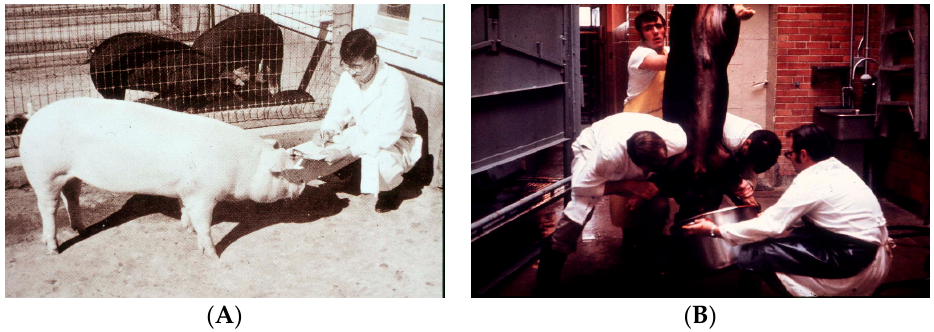
Figure 8. ( A ). This hog was treated with 6.25 mg vitamin D 2 by Dr. Suda; ( B ) the blood was then collected. After purification of the blood lipid extract, the vitamin D 2 metabolite was identified as 25-hydroxyvitamin D 2 . Holick copyright 2023. Reproduced with